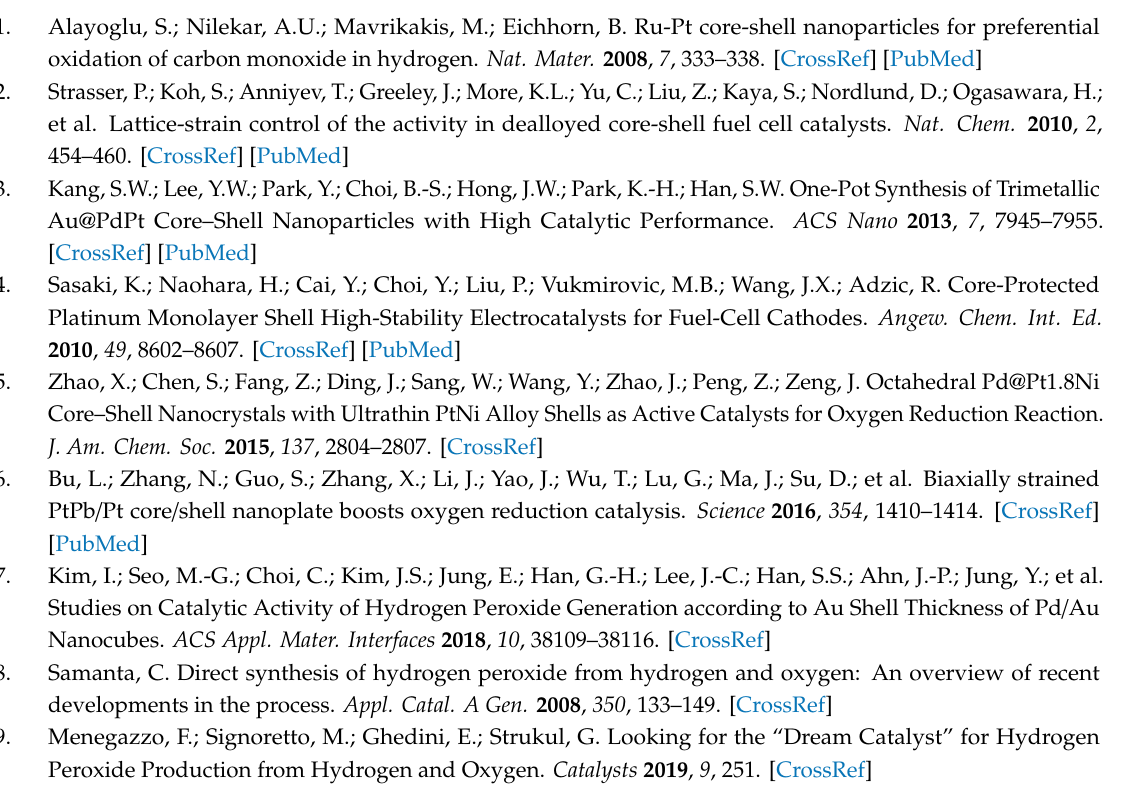
Figure S1: TEM image of Pd nanocubes as core materials, Figure S2: The EDS mapping images and average particle sizes of AuPt@Pd nanoparticles synthesized with varying mol % ratio of Au and Pt. The mol % of